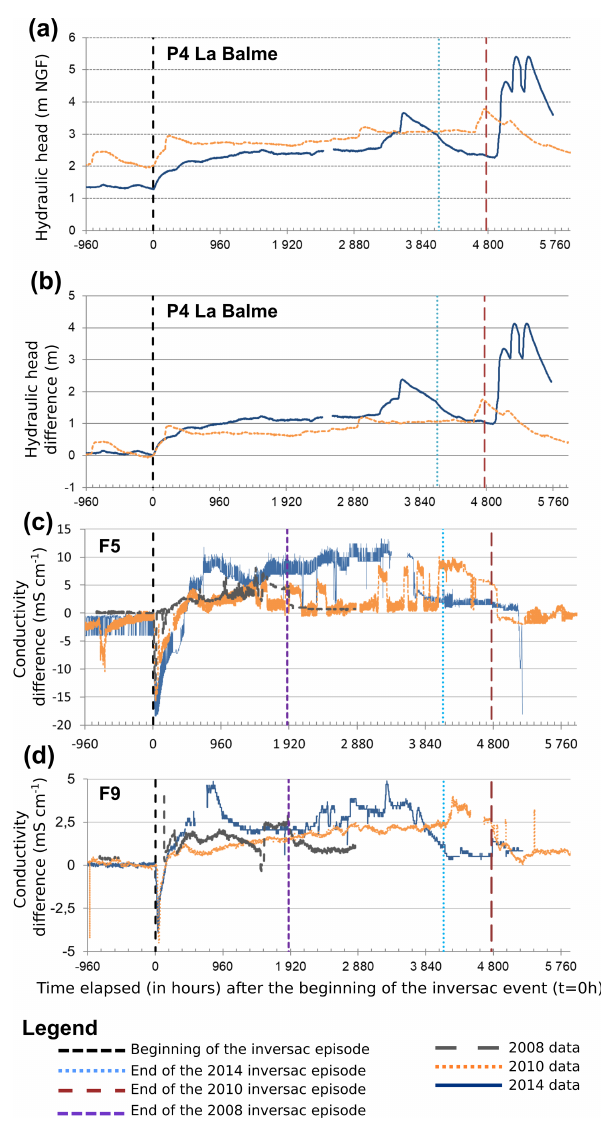
Figure 5. (a) Hydraulic head (m) and (b) hydraulic head varia- tion (m) of karst well P4 La Balme during the 2010 and 2014 inver- sac events; electrical conductivity variation (mScm − 1 ) for thermal wells (c) F5 and (d) F9 during the 2008, 2010, and 2014 inversac